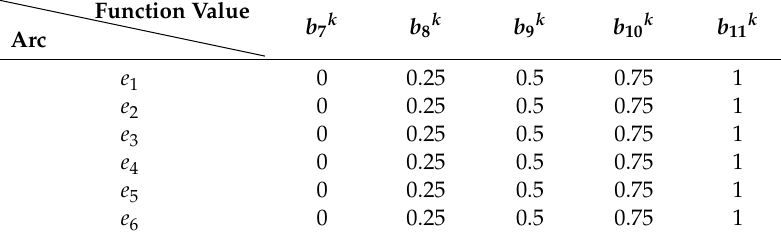
Table 3. Fuzzy function value of reliability for each